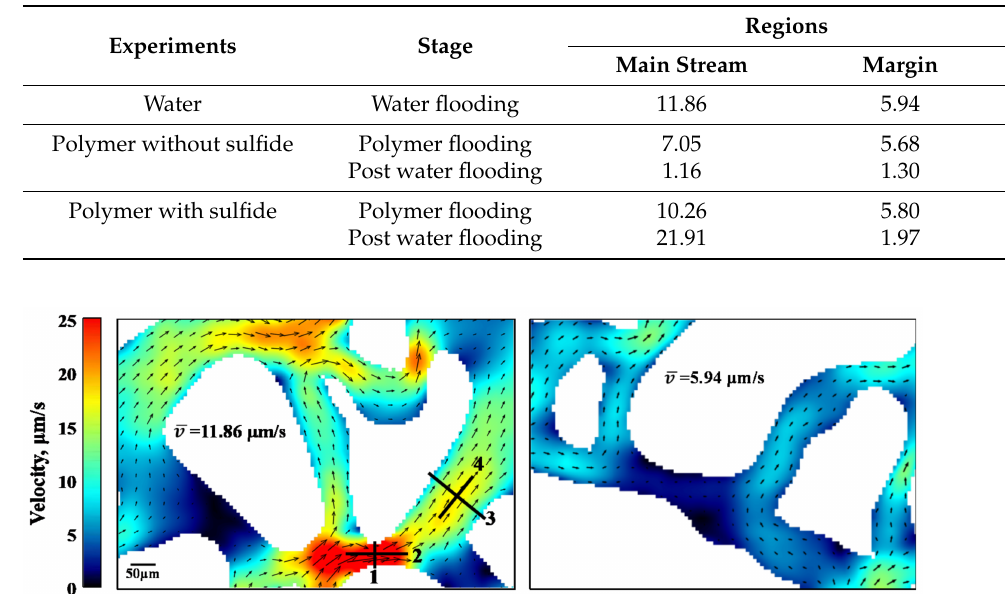
Table 1. Average velocity ( µ m/s) of the observed regions in the microscopic flow fields.